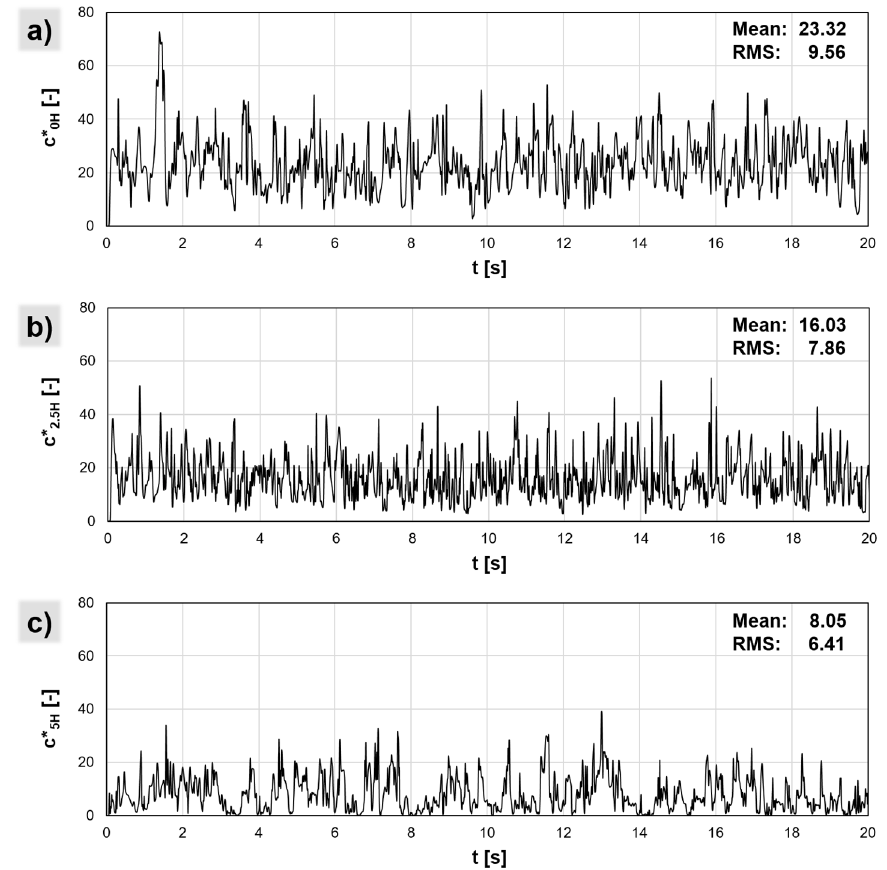
Figure 9. Time series of pointwise normalized concentrations over the leeward walkway, in z /H = 1/12 height and x /H = 1/6 distance from Building “A”. Lateral positions: ( a ) y /H = 0; ( b ) y /H = − 2.5; ( c ) y /H = − 5.